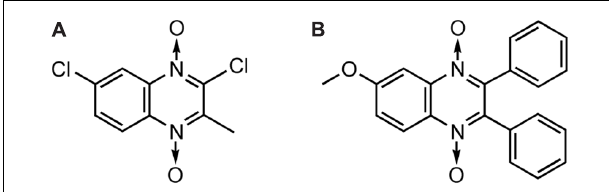
FIGURE 5 | General structures of QdNOs with antifungal